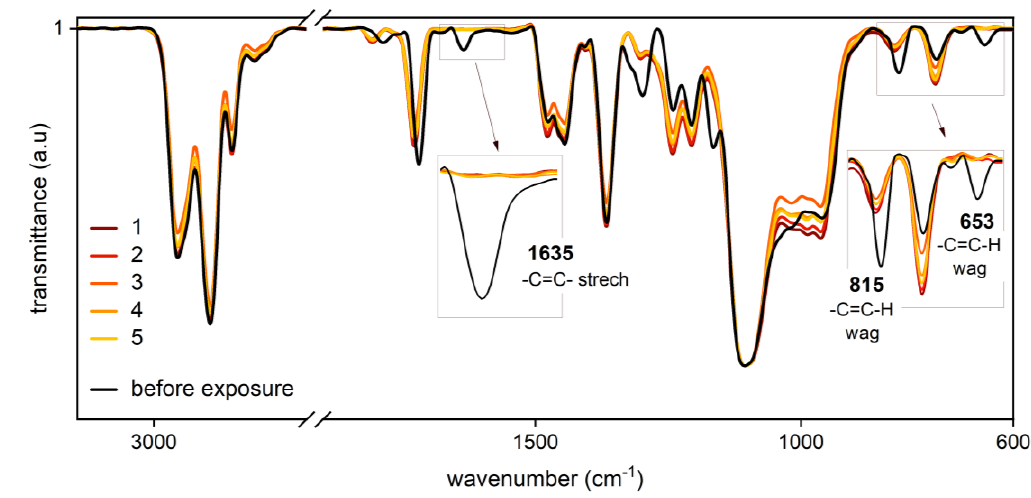
Figure 10. FT-IR spectroscopy of sections 1 – 5 (PBS A). The peaks related to carbon-carbon double bond units of the unpolymerized formulation at 1635, 815, and 653 cm ⁻ 1 vanish in each section after light induced polymerization.